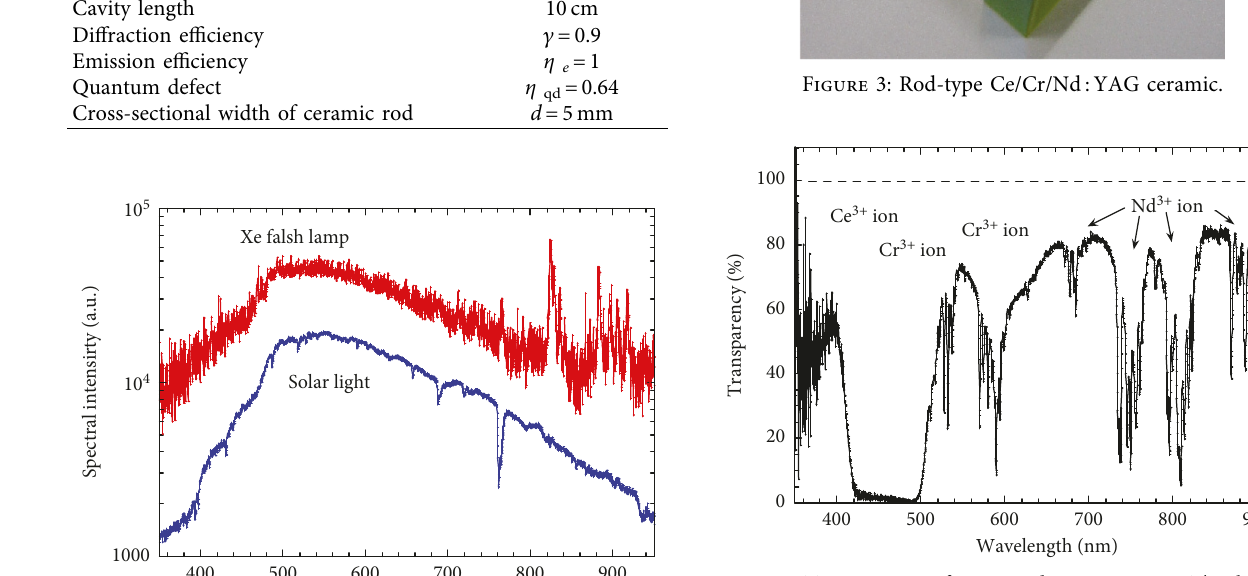
Figure 4: Transparency of Ce/Cr/Nd :YAG ceramic. The thickness is 5